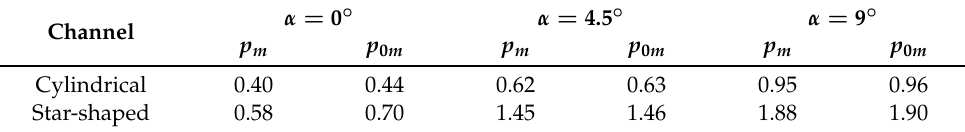
Figure 9. Distributions of static pressure ( a ) and total pressure ( b ) along stagnation line for various angles of nozzle rotations for star-shaped channel. Table 1. Maximal pressure (MPa) for the various angles of nozzle rotation.